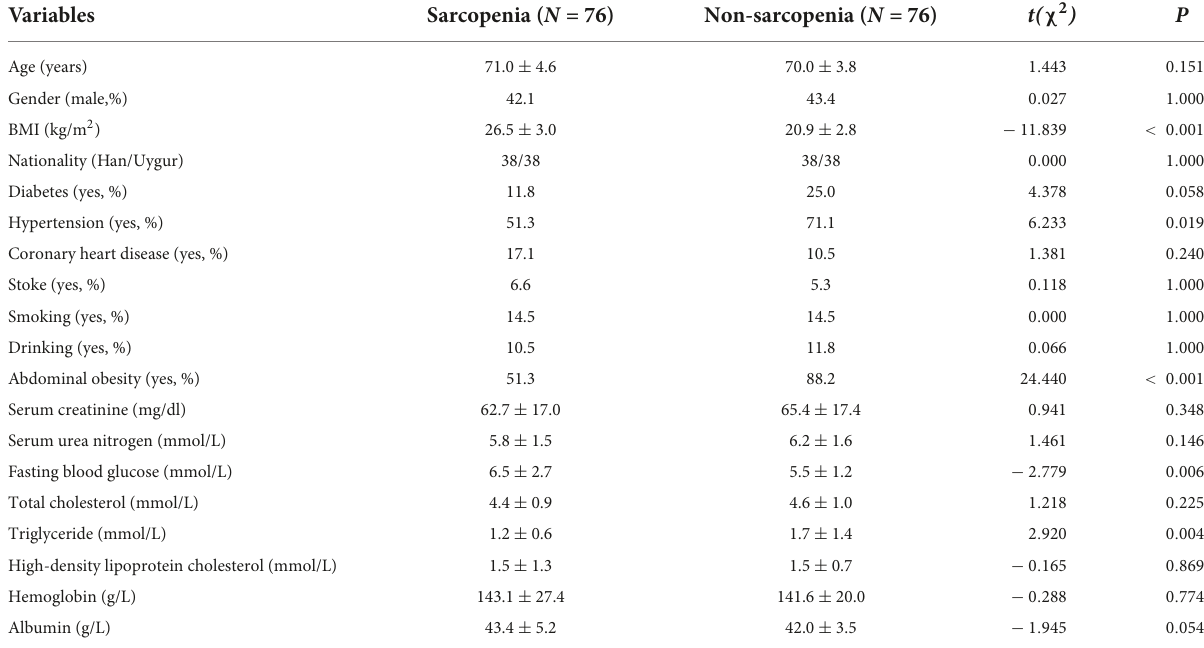
TABLE 1 Clinical data analysis of subjects.